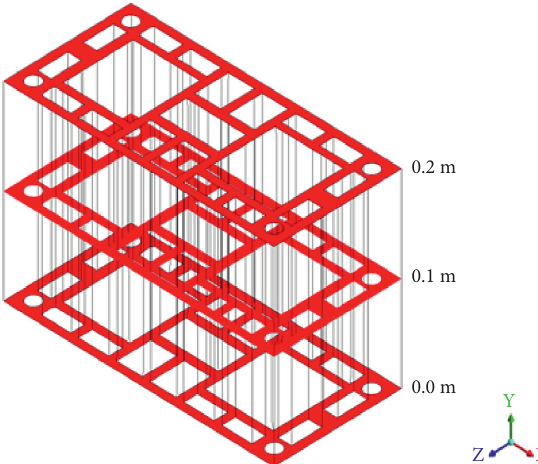
Figure 9: Sketch of the three different positions in y plane ( y � 0.0, 0.1, and 0.2 ° m) that were used for